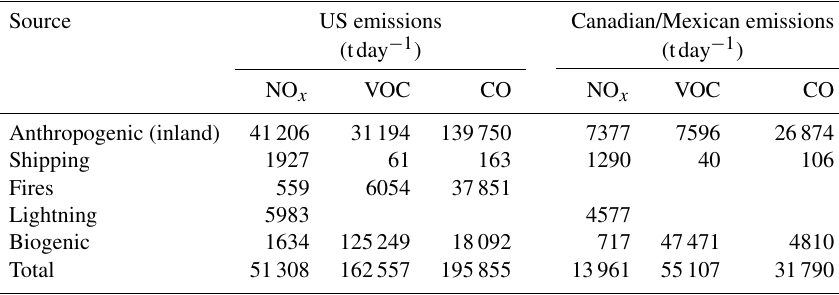
Table 1. Average daily emissions in the CAMx modeling domain for March–September 2010.